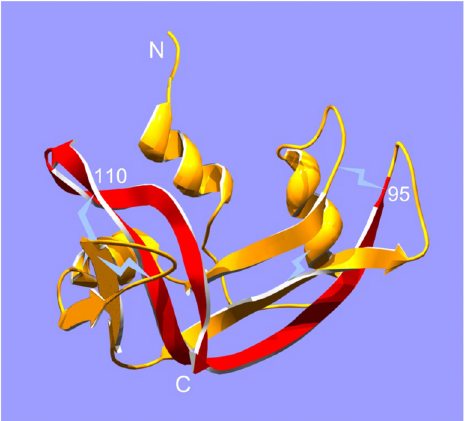
FIGURE 2. RNase A fragment 1–94 (orange, with an additional Met-1, not shown) is produced by biosynthesis. In intein-mediated protein ligation, it is ligated to RNase A fragment 95–124 (red), which is produced by chemical synthesis and can contain non-natural modules.